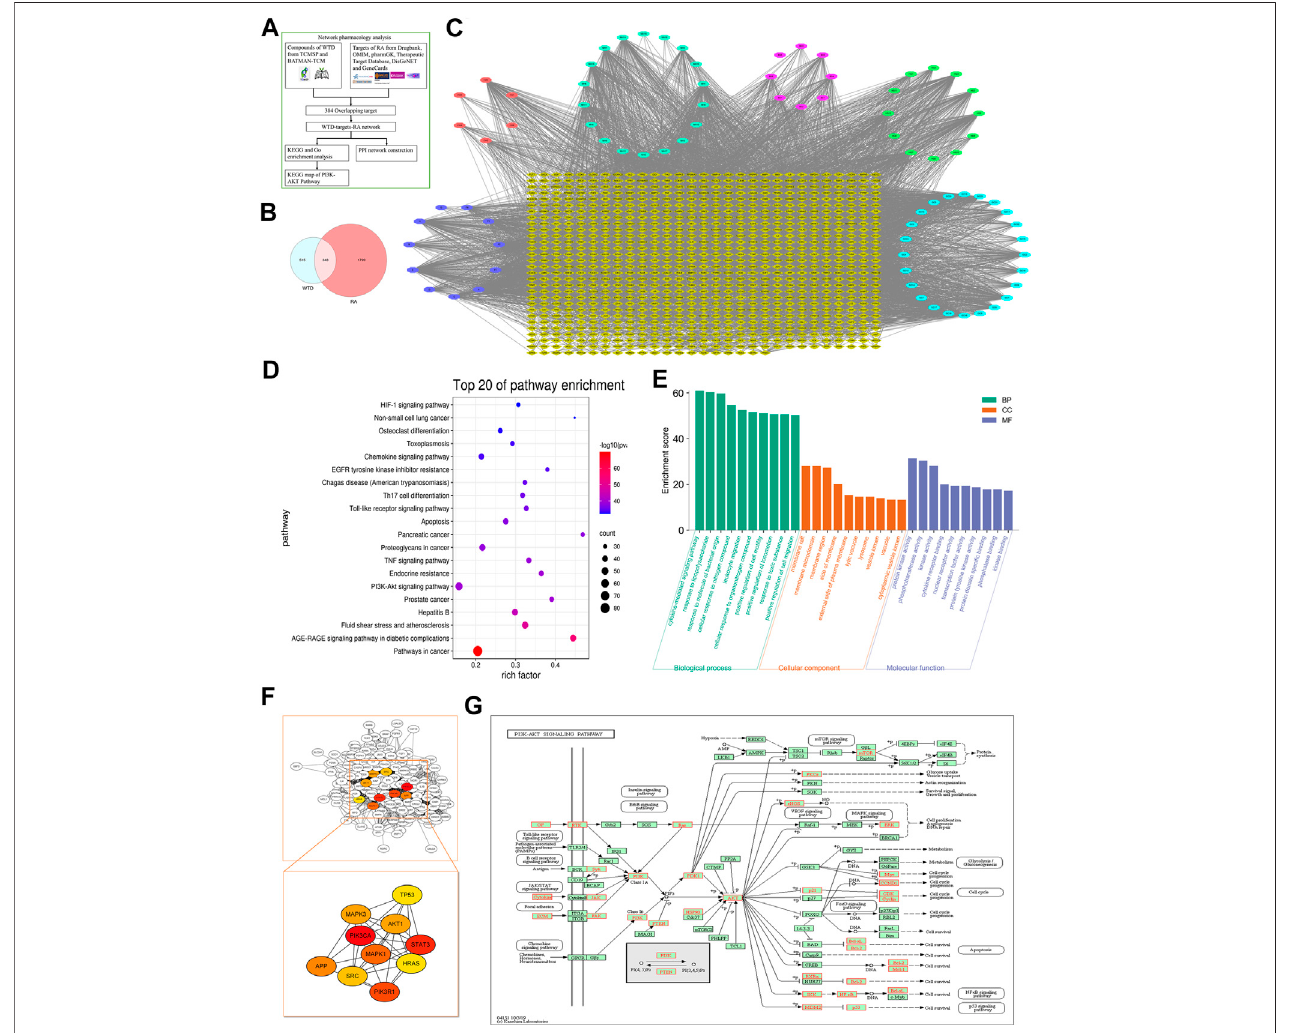
FIGURE 6 | Network pharmacology analysis indicated that WTD could exert antiangiogenic effects through the PI3K-AKT-mTOR pathway. (A) Network Pharmacology analysis fl owchart of WTD-regulated RA. (B) Venn diagram showing that 348 targets overlapped between WTD and RA, which were selected as the WTD-regulated RA targets. (C) The compound-target network was established by Cytoscape 3.8 software; the blue ellipse represents Glycyrrhiza Radix Preparata, the light blue ellipse represents Ephedrae Herba, the pink ellipse represents Paeoniae Radix Alba, the red ellipse represents Aconiti Radix Cocta , the green ellipse represents Astragali Radix , the purple ellipse represents the ingredients shared with two or more herbs, and the yellow diamonds represent WTD-regulated RA targets. (D) KEGG enrichment analysis and (E) GO enrichment analysis for the 348 WTD-regulated RA targets performed by the Metascape database. (F) Hub targets were identi fi ed from the PPI network using the Cytoscape plug-in MCODE. (G) The KEGG map of WTD-regulated targets in the PI3K-AKT-mTOR pathway. RA, Rheumatoid Arthritis; WTD, Wutou decoction; CW, Chuanwu; MH, Mahuang; BS, Baishao; HQ, Huangqi; GC, Gancao; BP, Biological process; CC, Cellular component; MF, Molecular